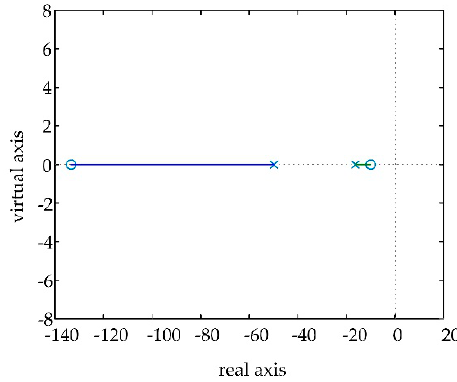
Figure 12. Root locus of the adaptive droop control converter station.